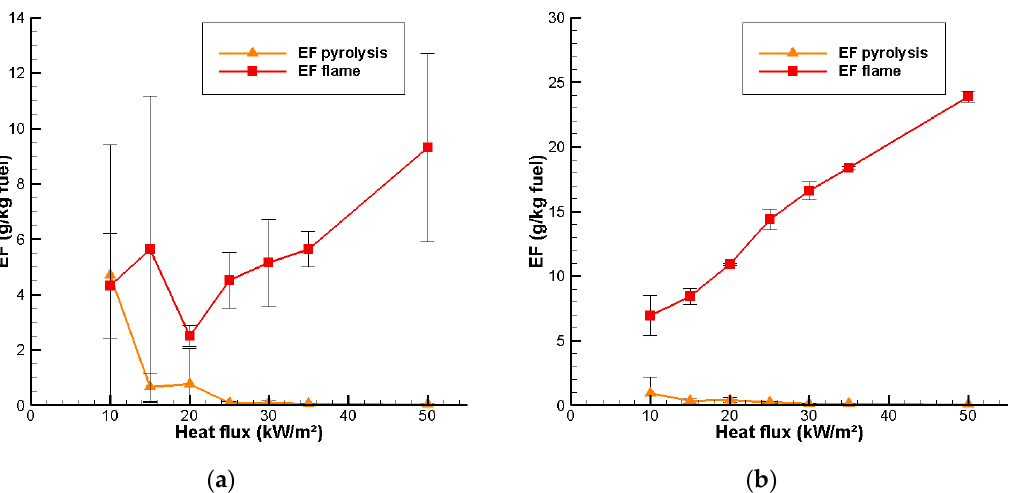
Figure 17. EF for aerosols for an imposed heat flux ranging from 10 to 50 kW/m 2 for ( a ) wood and ( b ) thermoplastic samples.